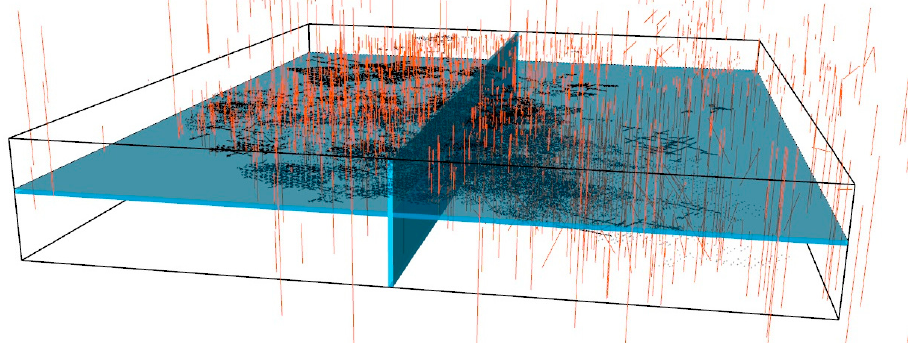
Figure 2. 3D view of boreholes and vertical section Px81 and horizontal section Pz75 used in the section images for displaying results.